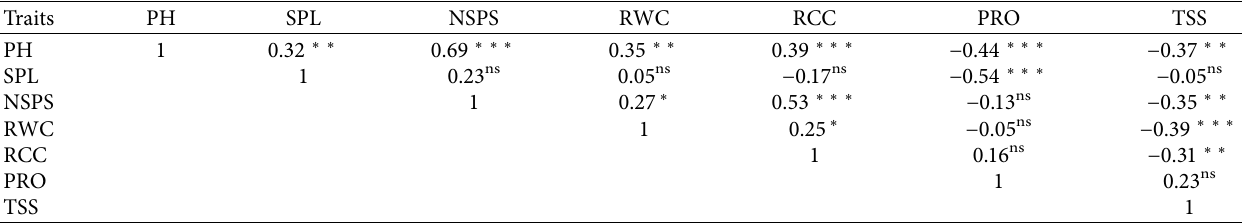
Table 6: Correlation coefficients for morphological, physiological, and biochemical parameters of wheat as affected by genotype and water